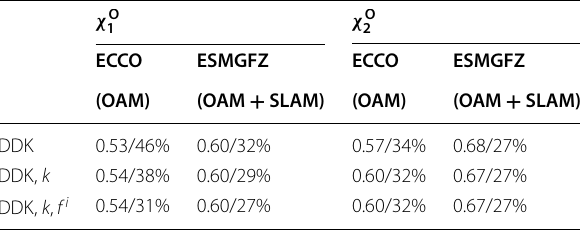
Table 2 Correlation coefficients and relative standard deviations (RSD) in percentage of the polar motion excitation functions for the oceans χ O derived from GRACE